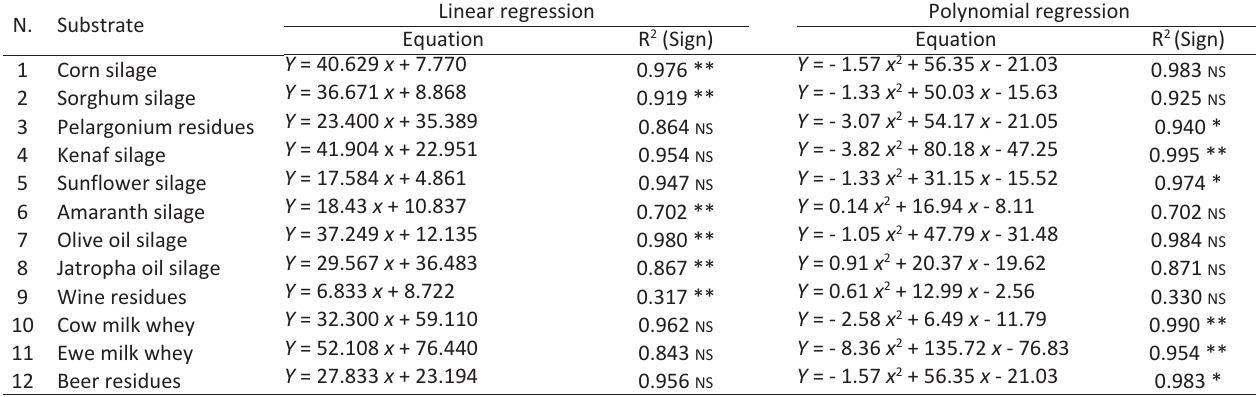
5 - Linear and polynomial regressions equations. R2 values and significance for the different substrate tested